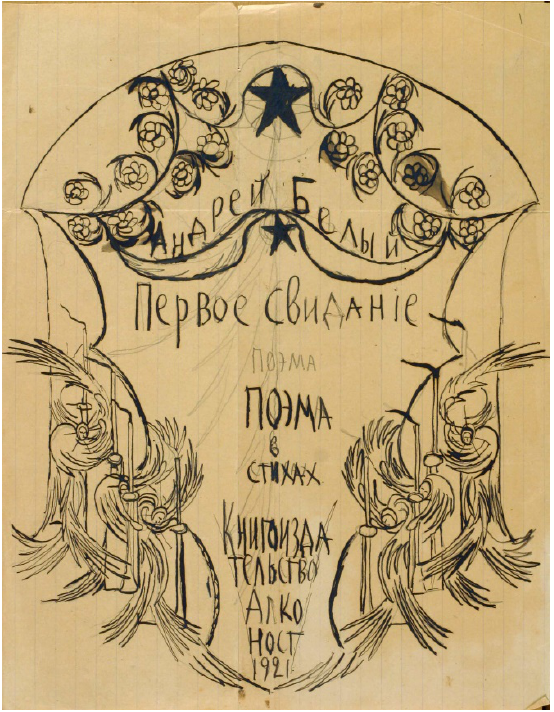
Figure 16. Andrei Bely. Sketch for the cover The First Encounter . 1921. RGALI.